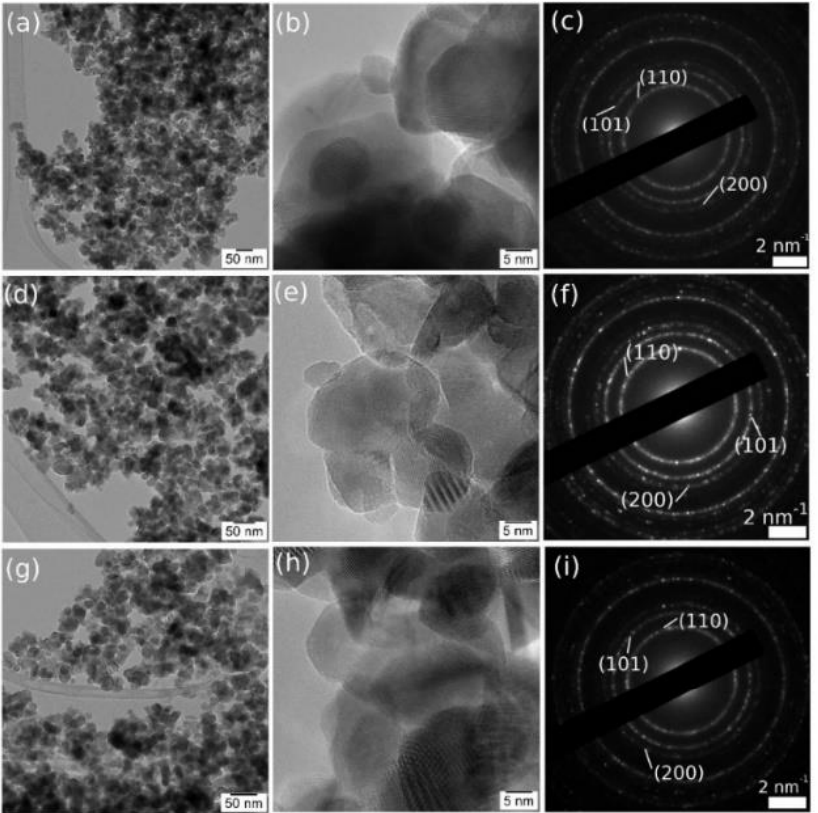
Figure 3. CTEM-HRTEM and large area SAED, respectively, of SnO 2 +1%NiO ( a – c ), SnO 2 +10%NiO ( d – f ) as compared with SnO 2 reference ( g – i ).